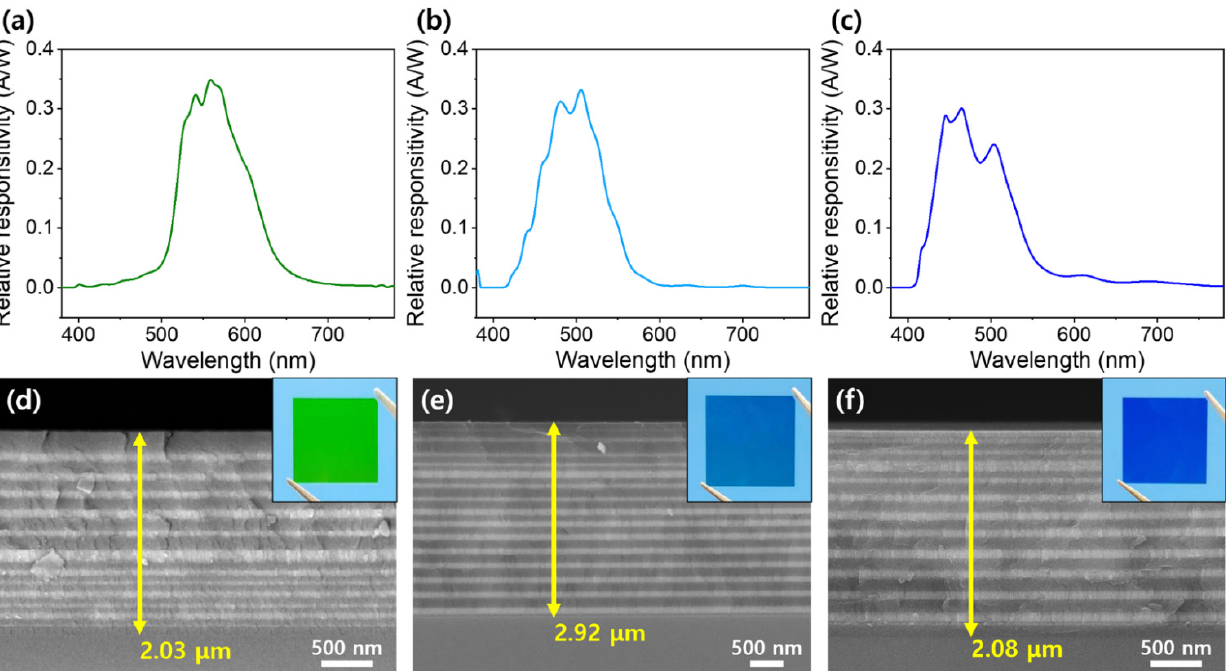
Figure 2. Relative responsivity of the fabricated circadian light meter. ( a ) VIL measurement channel (V-filter/photodiode), ( b ) melanopic EDI measurement channel (Mel-filter/photodiode), and ( c ) CIL measurement channel (C-filter/photodiode). The responsivity of each channel was calculated by weighting the transmittance of each filter to the responsivity of the photodiode. Cross-sectional view FE-SEM image with the backscattered electron detection mode of ( d ) V-filter, ( e ) Mel-filter, and ( f ) C-filter. The light and dark layers of the SEM images are TiO 2 and SiO 2 layer, respectively. The insets in each SEM image provide the photographs of fabricated the V-, Mel-, and C-filters.